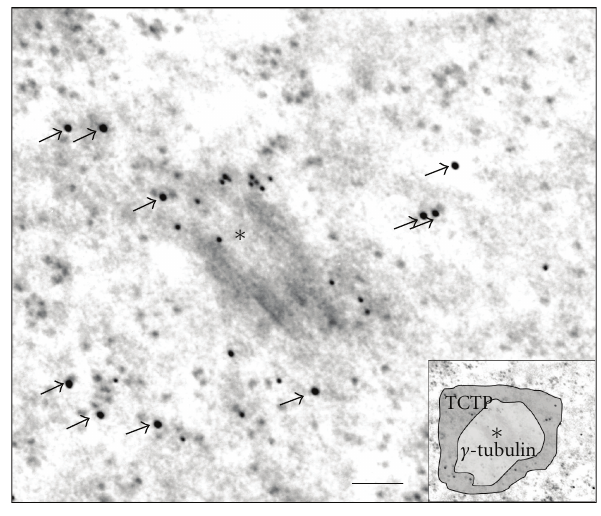
Figure 6: Double labeling of γ -tubulin and TCTP in the centro- some of Xenopus laevis oogonium. Centriole labeled with black asterisk; 18nm gold particles (black arrows) correspond to the presence of TCTP, small, and 10 nm gold particles around the centriole mark the presence of γ -tubulin. Inset in the bottom right corner shows the central area around the centriole where γ -tubulin is present (clear central area), and the TCTP-containing external area of the centrosome (dark grey). Bar is equal to 100